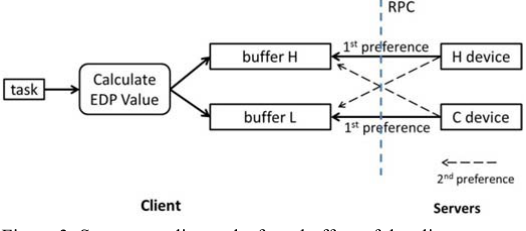
Figure 3: Servers stealing tasks from buffers of the